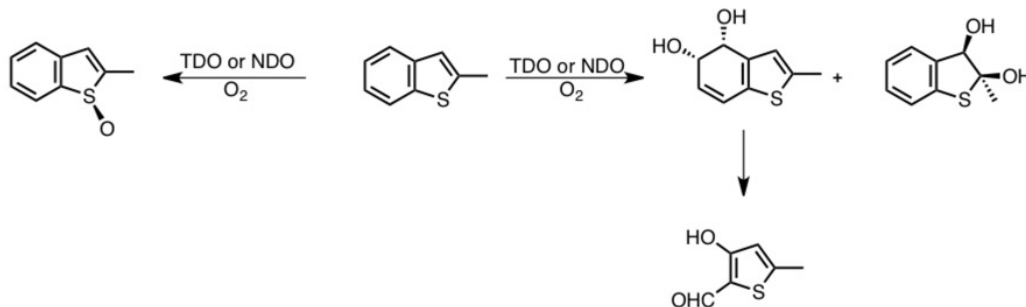
Figure 24 - Dioxygenase-catalysed oxidation of 2-MB[b]T.